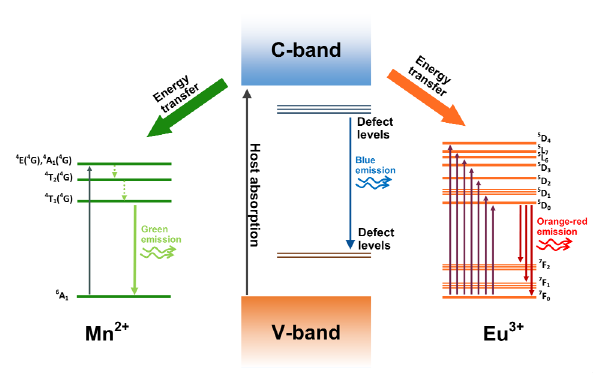
Fig. 7 Schematic energy-level diagram of Eu 3+ and Mn 2+ in MgGa 2 O 4 :Mn 2+ ,Eu 3+